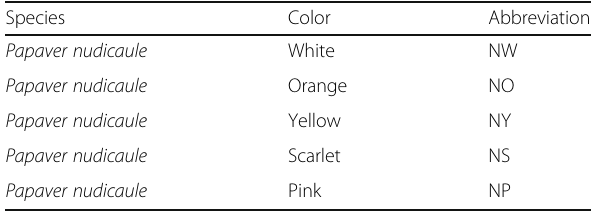
Table 1 Five kinds of Papaver nudicaule with different flower color and the